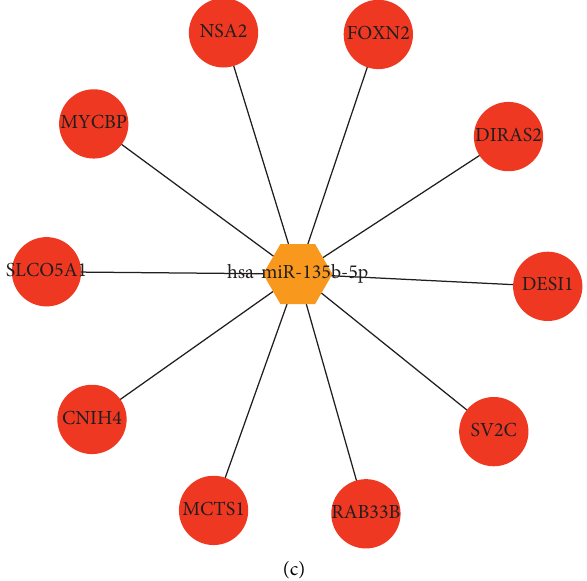
Figure 6: PPI network and hsa-miR-135b-5p-target gene regulatory network. (a) PPI network. (b) Te overlapped genes. (c) hsa-miR-135b- 5p-target gene regulatory network. Red and green colors represent up and downregulated mRNAs, respectively, and a bigger node indicates a higher degree. PPI, protein-protein interaction.